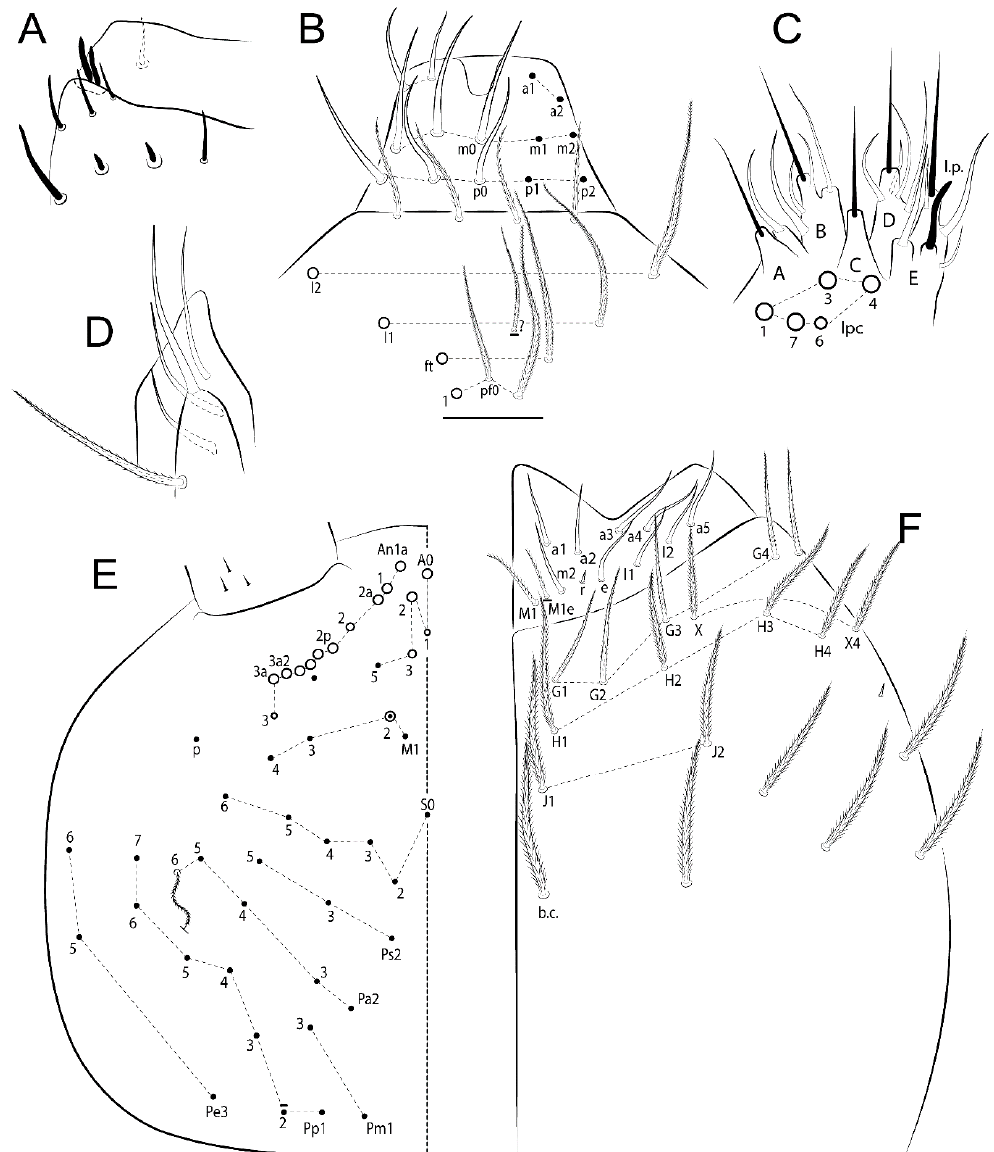
Figure 46. Pseudosinella diamantinensis sp. nov.: head. ( A ) Ant III apical organ (ventro-lateral view); ( B ) chaetotaxy of clypeus, prelabrum, and labrum; ( C ) labial papillae (H omitted) plus proximal chaetae; ( D ) maxillary palp and sublobal plate (left side), minute appendage omitted; ( E ) head dorsal chaetotaxy (left side); ( F ) basomedian and basolateral labial fields and complete postlabial chaetotaxy (right side).